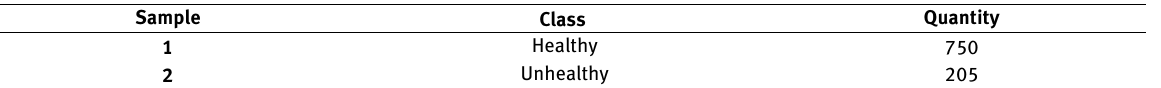
Table 2: Results of K-mean clustering